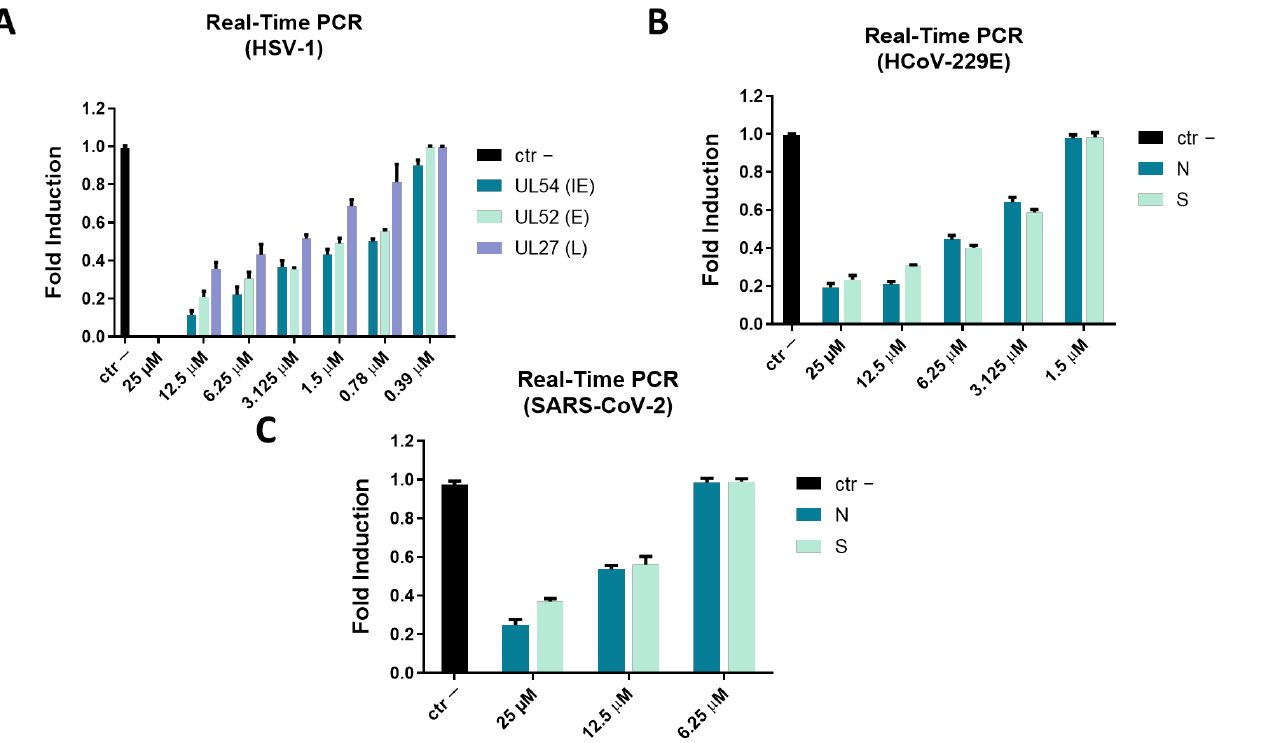
Figure 9. Molecular assay. Real-time PCR was performed to evaluate the effect of AR-23 on viral gene expression. Virus pre-treatment assay was performed, RNA was extracted after 24 h, retro-transcribed into cDNA and amplified by real-time PCR. The expression of UL54, UL52, and UL27 genes was analyzed for HSV-1 ( A ). The expression of N and S was evaluated for HCoV-229E ( B ) and SARS-CoV-2 ( C ). Ctr- refers to infected but not treated cells.